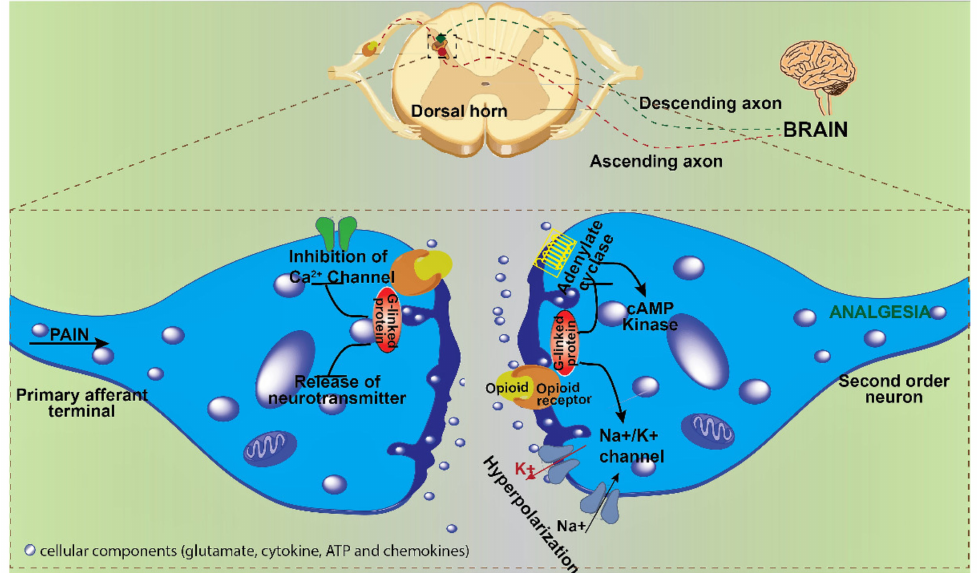
Figure 2. Mode of action of opioids in pain suppression at the cellular level. The binding of opioids to opioid receptors inhibits the calcium channel and blocks the release of neurotransmitters (represented as silver blobs in synaptic space, which get depleted upon binding of opioids) in the presynaptic neuron. In the postsynaptic neuron, the binding of opioids leads to hyperpolarization, preventing the transmission of the signal of pain and hence analgesia. (The image is illustrated with software chembio draw v.19 and Adobe Illustrator